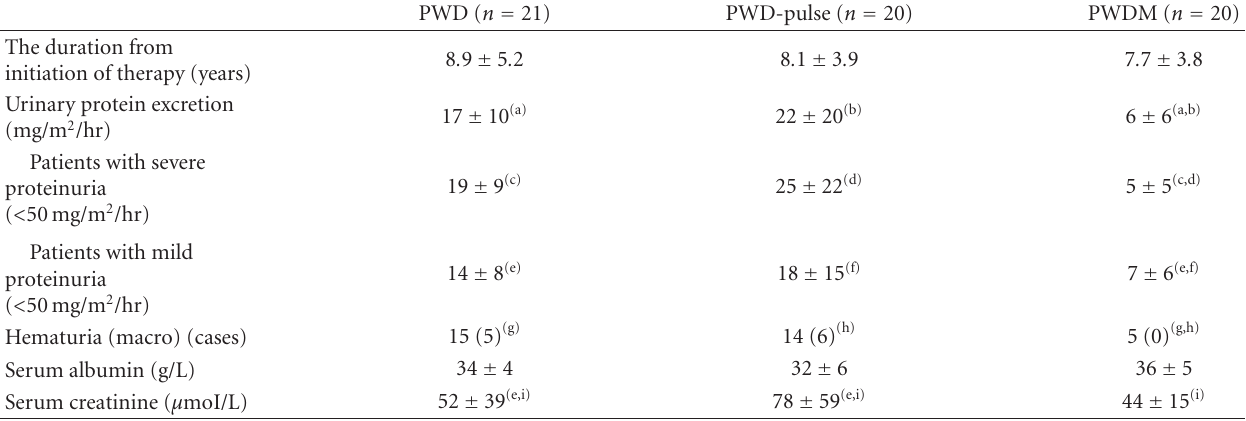
Table 3: Comparison between laboratory findings in the three groups at the latest follow-up examination.